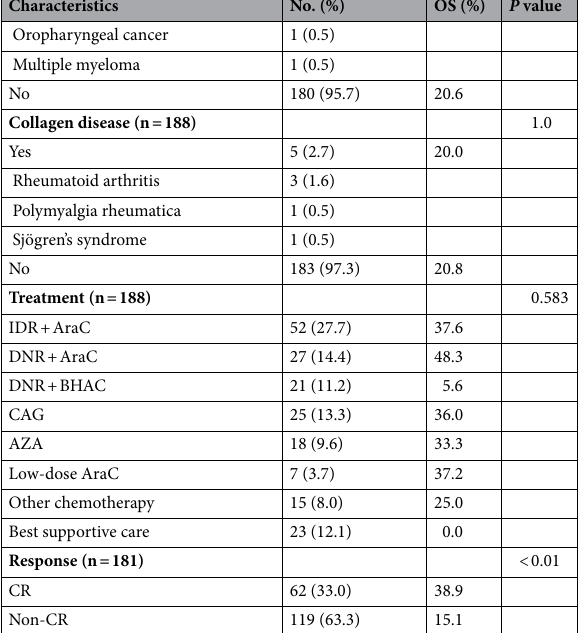
Table 1. Patient characteristics and univariate analysis of the risk factors associated with 2-year OS. CRP C-reactive protein, TLC total lymphocyte count, Alb albumin, T-Chol total cholestero, IDR idarubicin,